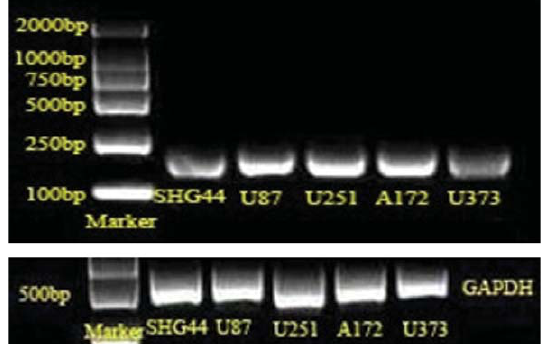
Fig. 1. The expression of RNF138mRNA in the 5gliomas cell lines by